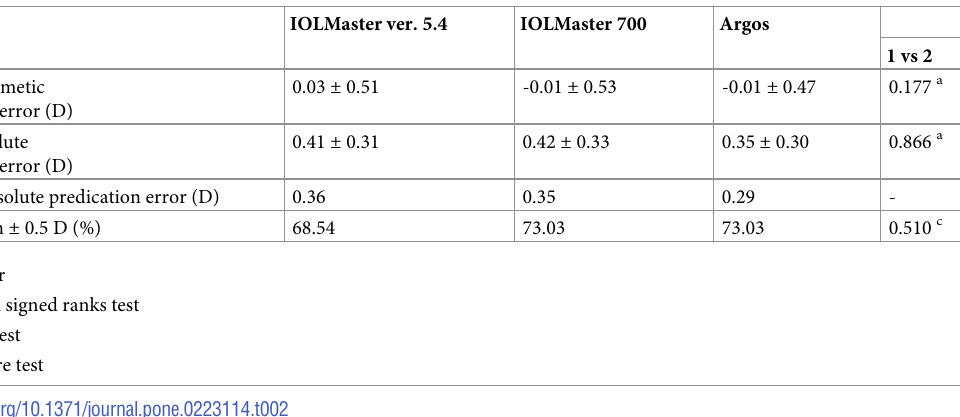
Table 2. Comparison of postoperative refractive errors between the three